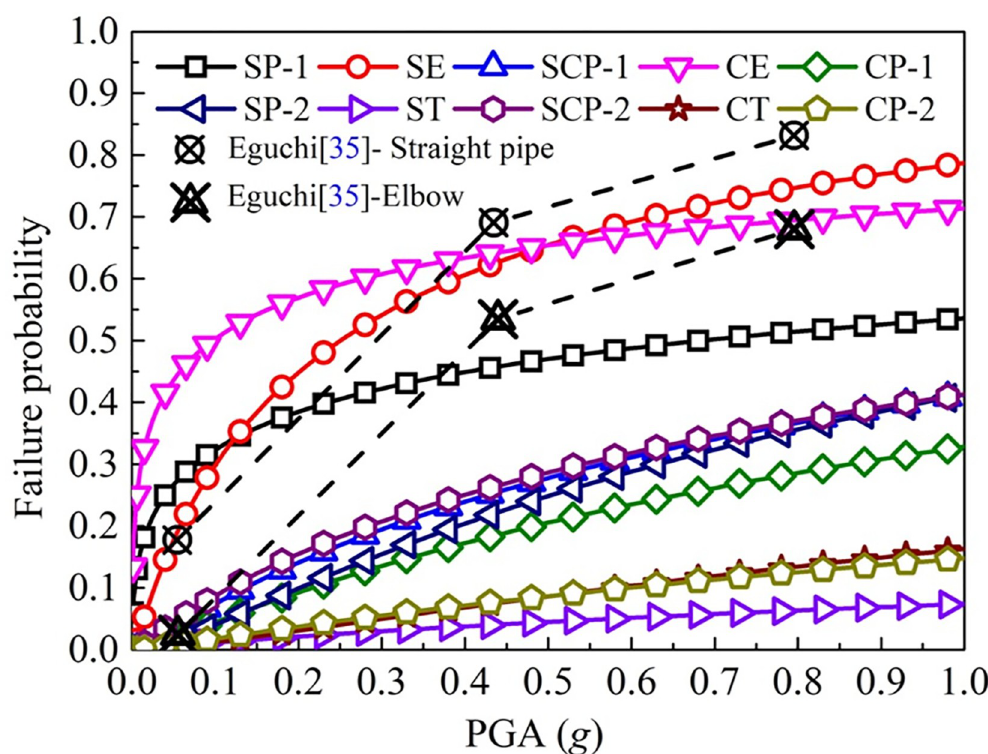
Fig 5. Probability of leakage failure of pipe components [35]. Note: The elbows in sand and clay are represented by SE and CE respectively; the straight pipes connected to the elbow in sand and clay are represented by SP-1 and CP-1 respectively; the straight pipe connected to the elbows in the mixed soil is represented by SCP-1; the tees in sand and clay are represented by ST and CT respectively; the straight pipe connected to the tee in sand and clay is represented by SP-2 and CP-2 respectively; the straight pipe connected to the tees in mixed soil is represented by SCP-2.